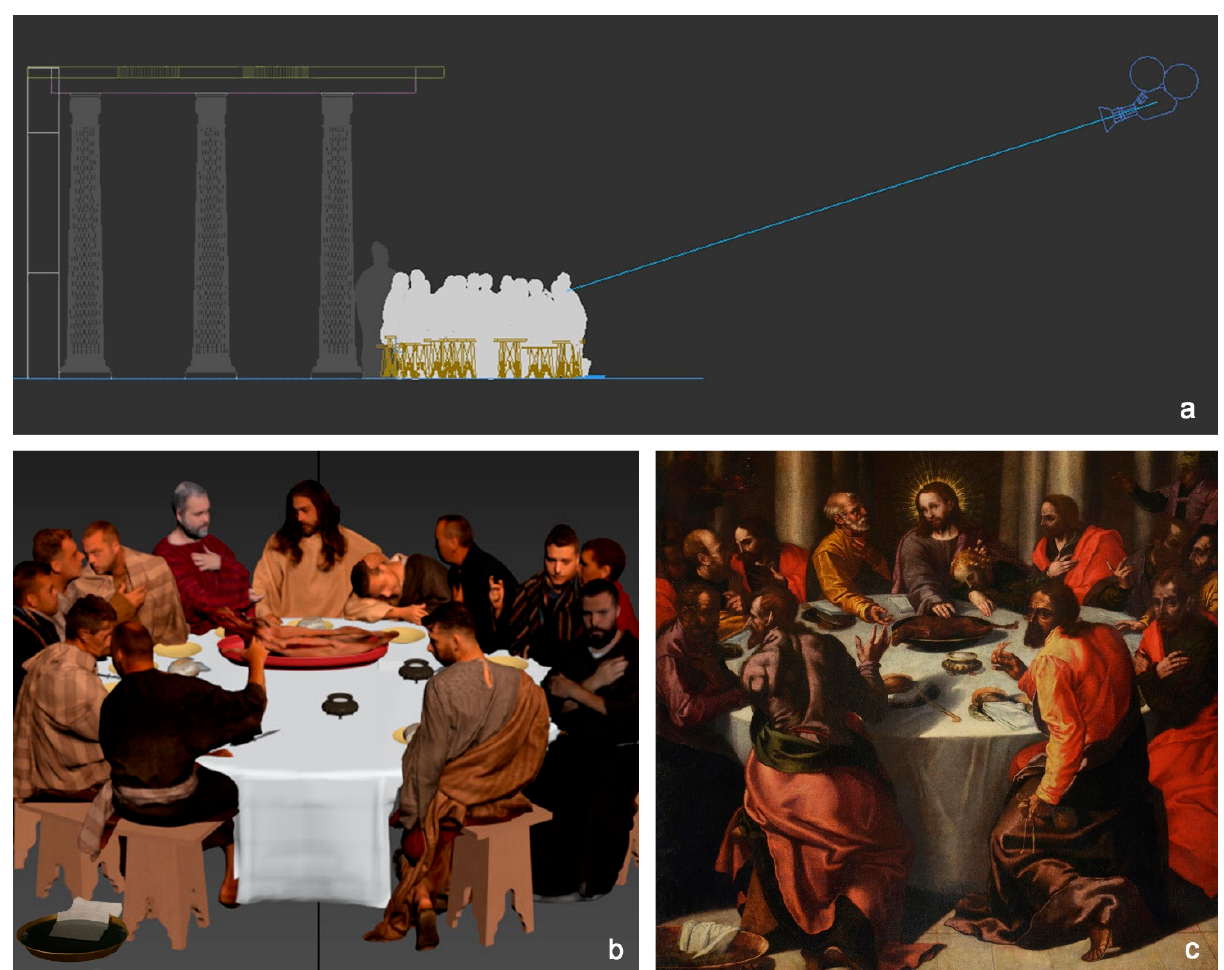
Figure 15. ( a ) Side view of the scene with enlargement of the characters and position of the camera at 6 m from the ground (50 mm camera); ( b ) image taken from the reconstruction of the virtual model with enlargement of the characters and position of the camera at 6 m from the ground; ( c ) G. Hovic, Last Supper.